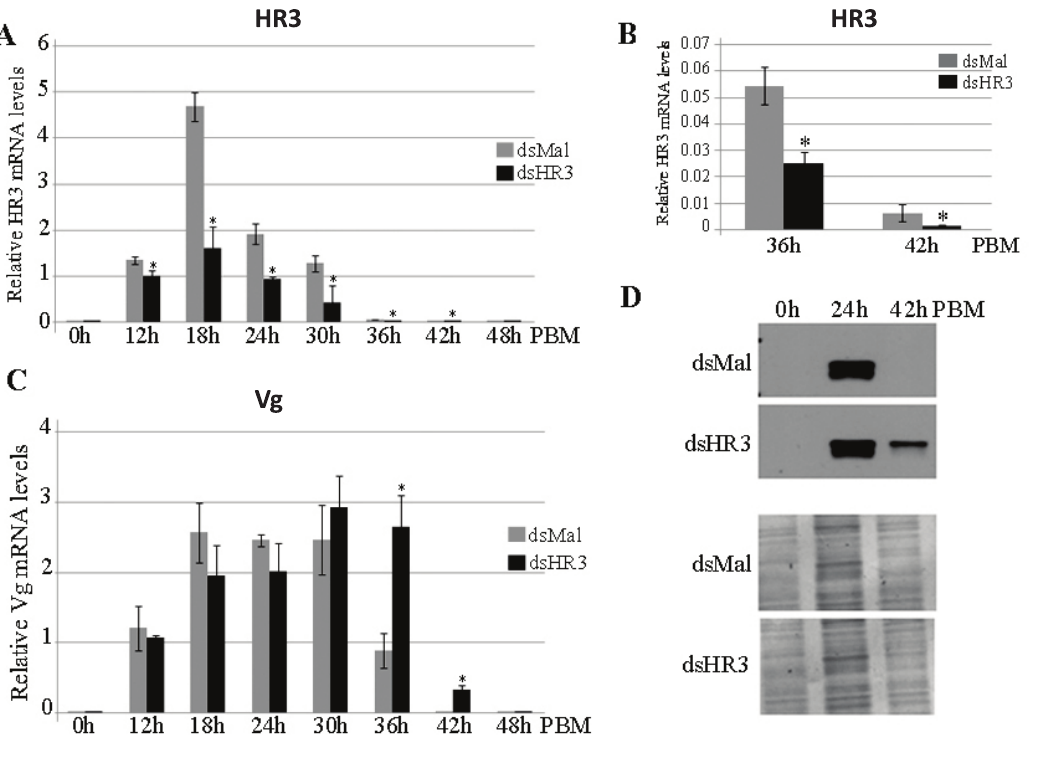
Figure 1. HR3-knockdown Aedes mosquitoes showed a delay in impaired vitellogenin (Vg) mRNA and Vg protein levels at the end of vitellogenesis in the fat body. (A–C) Female mosquitoes were injected with 1 m g dsHR3 or dsMal RNAi, as described in Materials and Methods. HR3 (A and B) and Vg (C) mRNA expression was measured using qPCR at the indicated time points after blood feeding (PBM). Point 0h represents 72h post-eclosion in female mosquitoes prior to blood feeding; this was used as a reference control. Data are expressed as fold induction relative to S7. Data (means + standard errors of the means) from three independent experiments are shown. *Indicates statistical significance , 0.05. (B) Magnification scale of the 36-h and 42-h PBM time points from the same experiment shown in A to demonstrate details of the HR3 depletion at the end of the vitellogenic cycle. (C) Monitoring the Vg transcript abundance in the same experiments as in A. A high level of the Vg transcript was observed in FBs of HR3-depleted female mosquitoes at 36 h PBM showing a delayed high expression of the Vg gene. (D) Western blot analysis of Vg protein during several time points of the first gonadotrophic cycle in the fat body of female mosquitoes treated with dsMal or dsHR3 RNAi. A total of 0.01 fat body equivalents was loaded in each lane for SDS/PAGE. A mixture of nine monoclonal antibodies against Vg small subunit was used for Vg protein detection (upper panels). Lower panels with Comassie-stained SDS/PAGE gels used for the western blot experiment are presented as loading controls. Three independent replicates of the experiment were